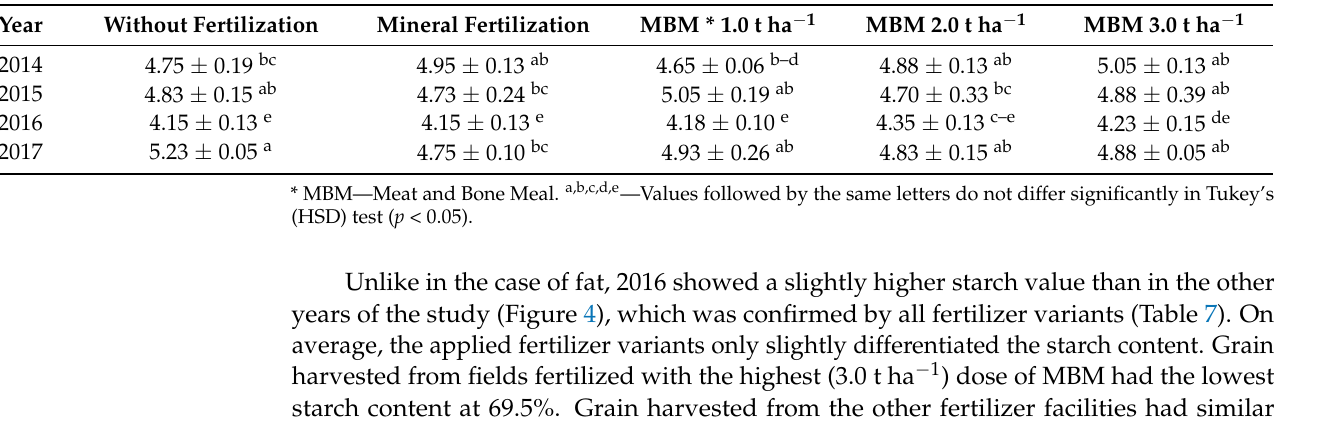
Table 6. The fat content in corn grains (mean value and standard deviation), interaction between the years and treatments %.